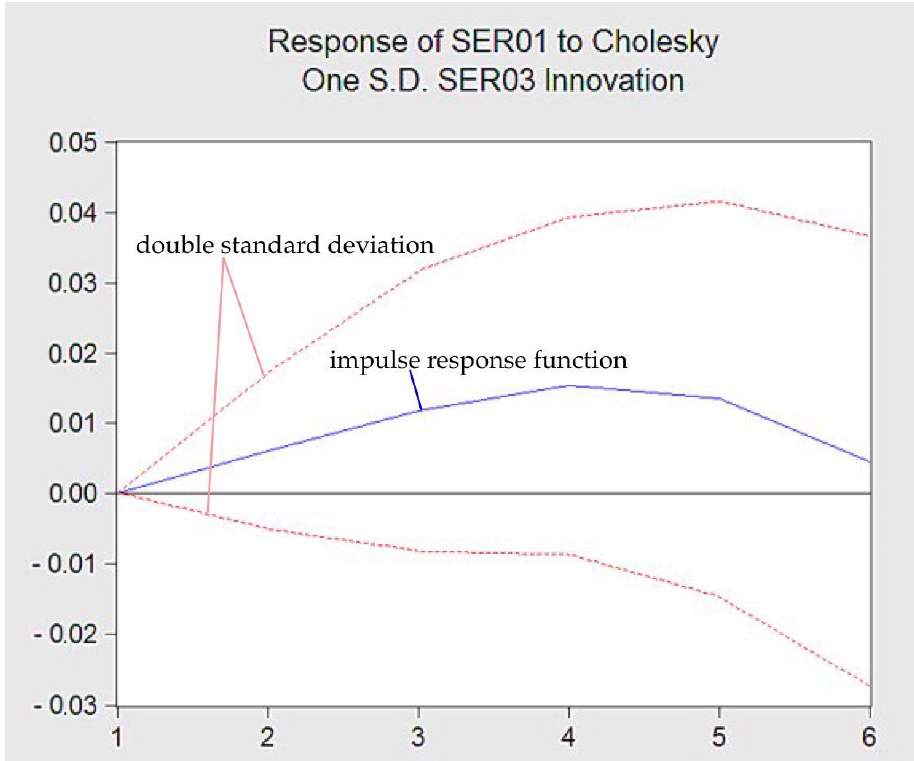
Figure 8. Impulse Response of carbon emissions to foreign trade.